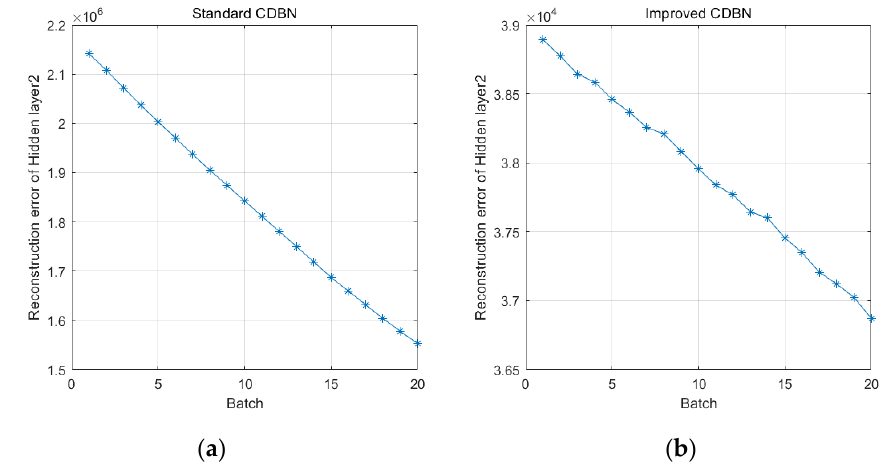
Figure 12. Comparison of second-layer reconstruction error when training ( a ) standard CDBN and ( b ) improved CDBN.